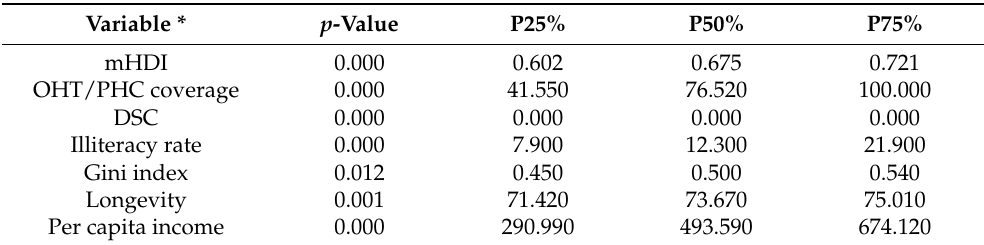
Table 3. Descriptive analysis of contextual variables from municipalities (n = 279) that requested teleconsulting sessions.